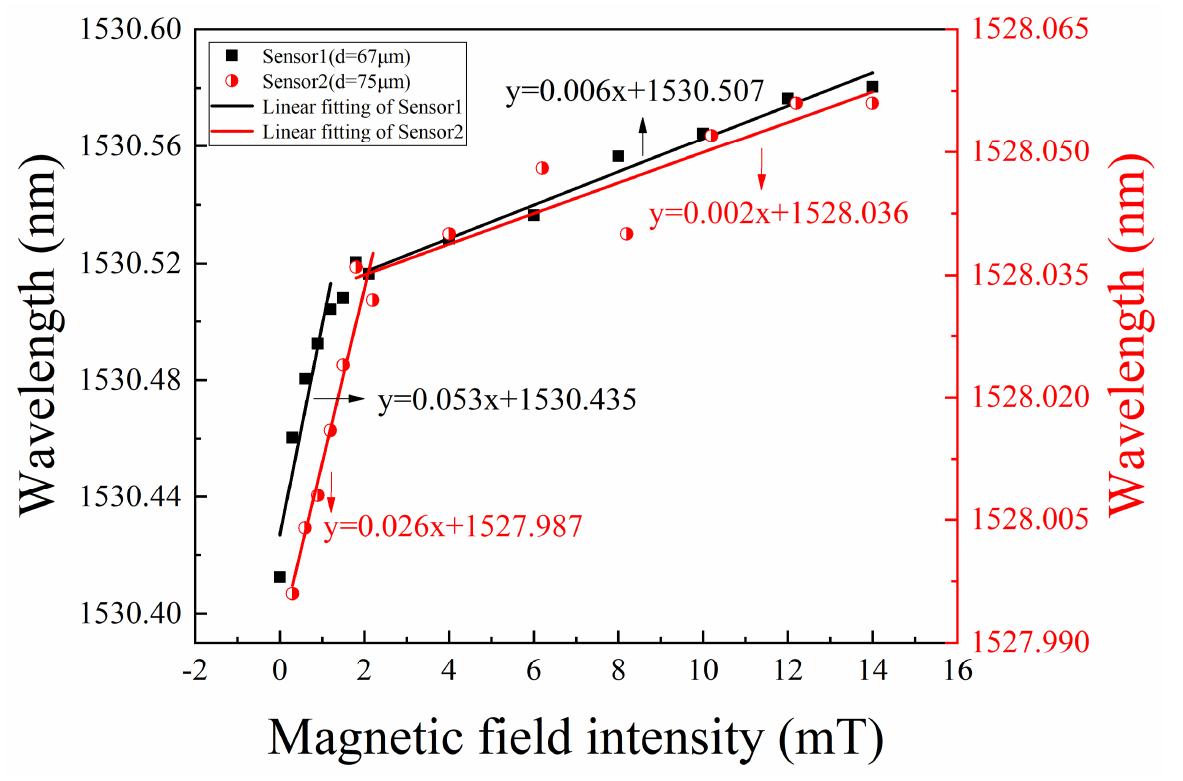
Figure 7. WGM resonant wavelength as a function of applied magnetic field for the PCF microcavity with diameter of d = 67 and 75 µ m,